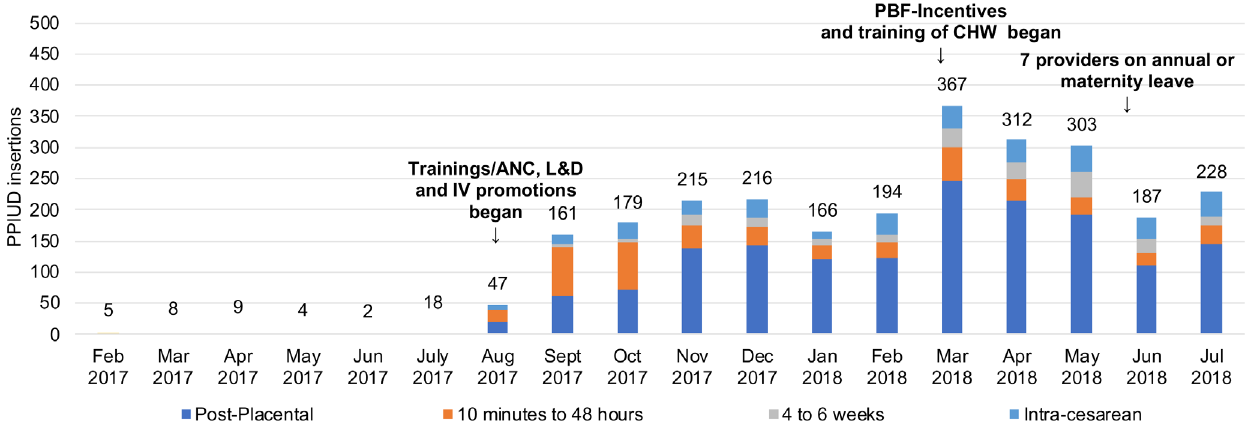
Figure 3. PPIUD Insertions over time by insertion timing (N = 2,575 total PPIUD insertions). PPIUD: postpartum intrauterine device; CHW: community health worker; PBF: performance-based financing; ANC: antenatal care; L&D: labor and delivery; IV: infant vaccination.